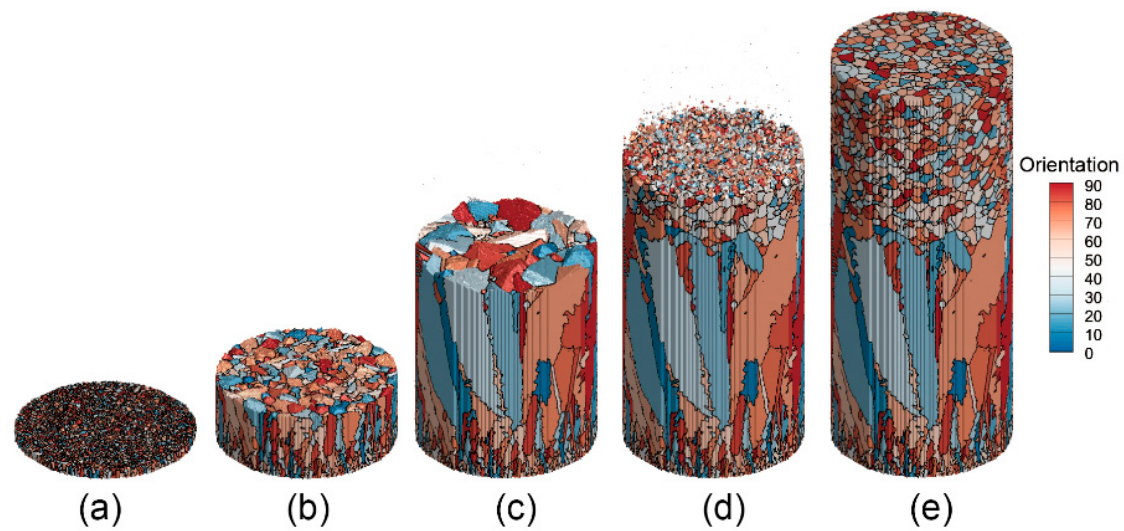
Figure 12. Grain structure in 3D simulation at different times: ( a ) 250 s; ( b ) 400 s; ( c ) 800 s; ( d ) 1000 s; ( e ) 1200 s.